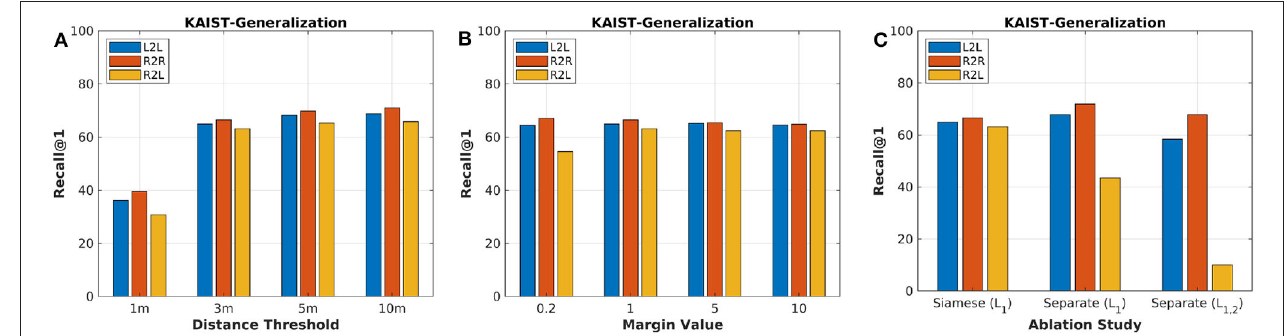
FIGURE 4 | (A) The parameter sensitivity study of distance thresholds for evaluation. (B) The parameter sensitivity study of margin values for training. (C) The ablation study of proposed framework and loss